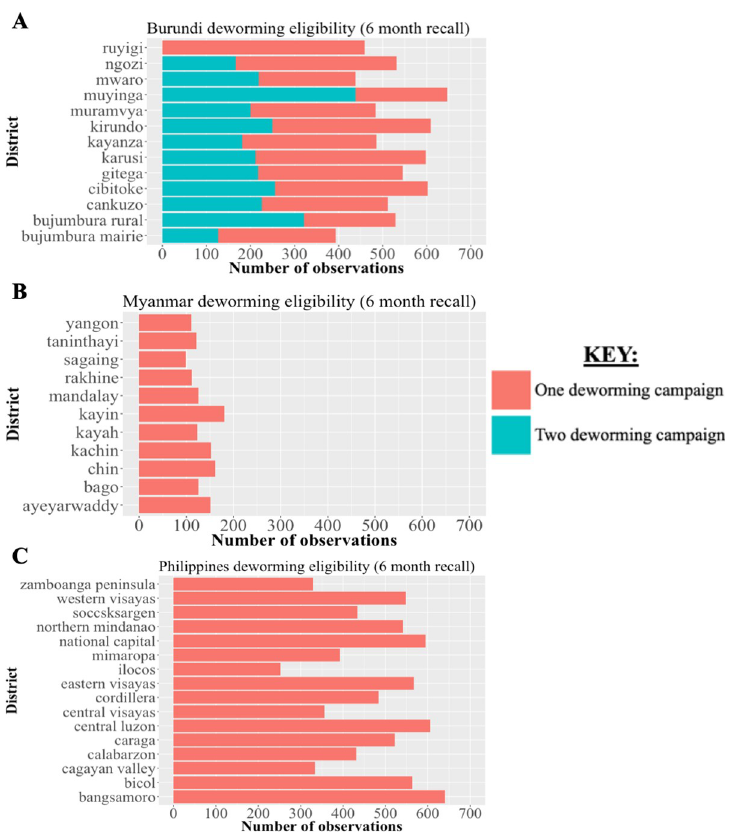
Fig 3. District-level sample size of DHS observations used to estimate deworming coverage in study countries. We determined the sample size of DHS respondents at a district-level and estimated the proportion eligible for one or two deworming campaigns based on the maternal recall period used for DHS observation inclusion. These data are visualized for Burundi (panel A), Myanmar (panel B), and the Philippines (panel C) each with a base case recall period of 6 months based on formulation of the original DHS question for deworming